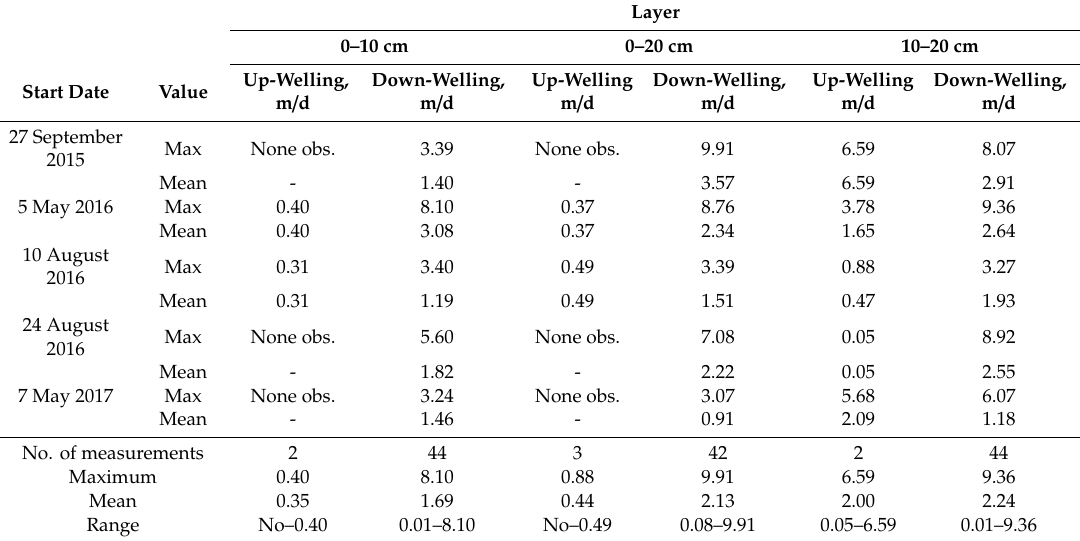
Table 2. Summary of vertical water flux measurements for the Kingfisher restoration site.